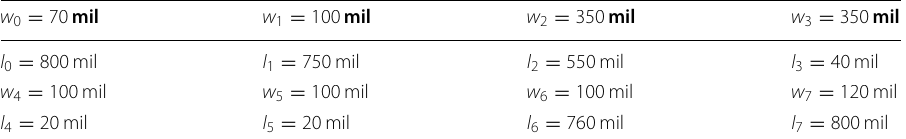
Table 1 Dimensions in the PLM Unit